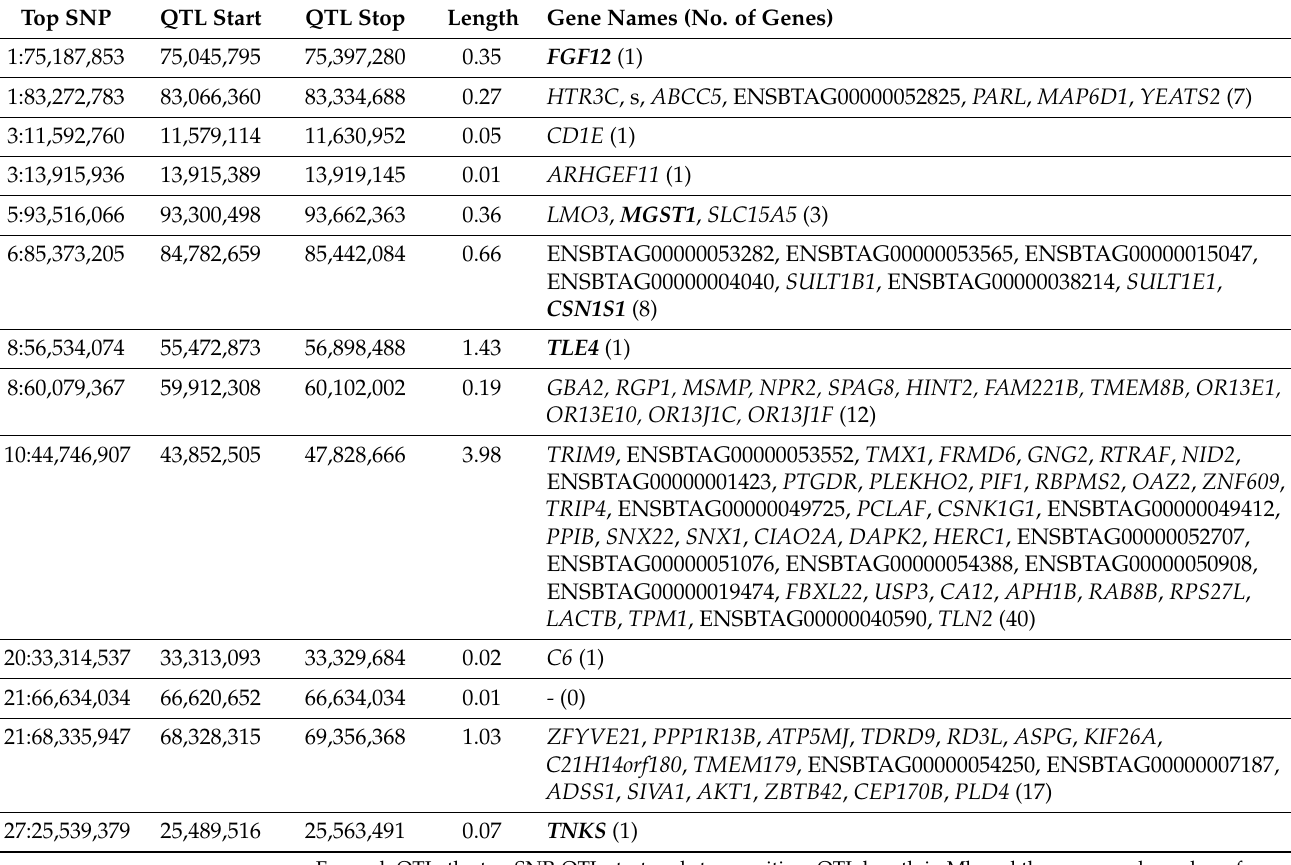
Table 2. Candidate genes in QTL regions significantly associated with milk production traits in